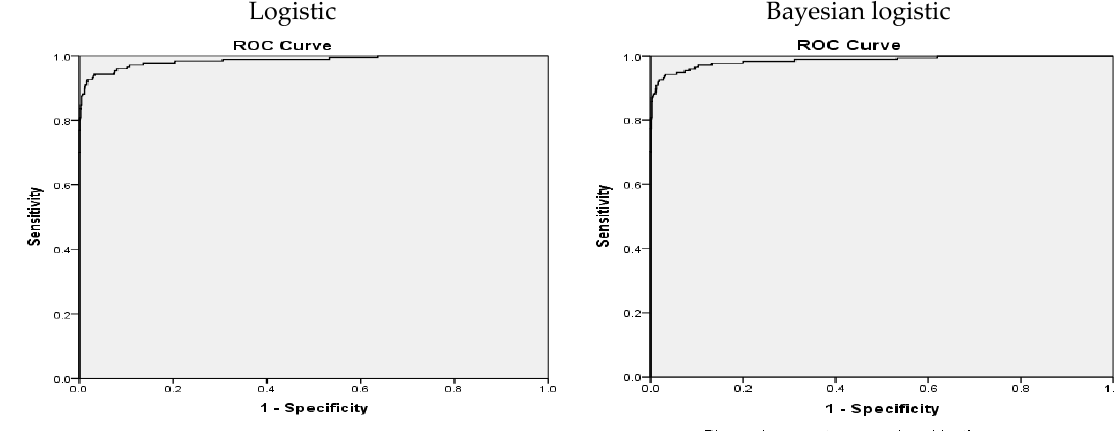
Figure 1. Receiver operating characteristic curve.